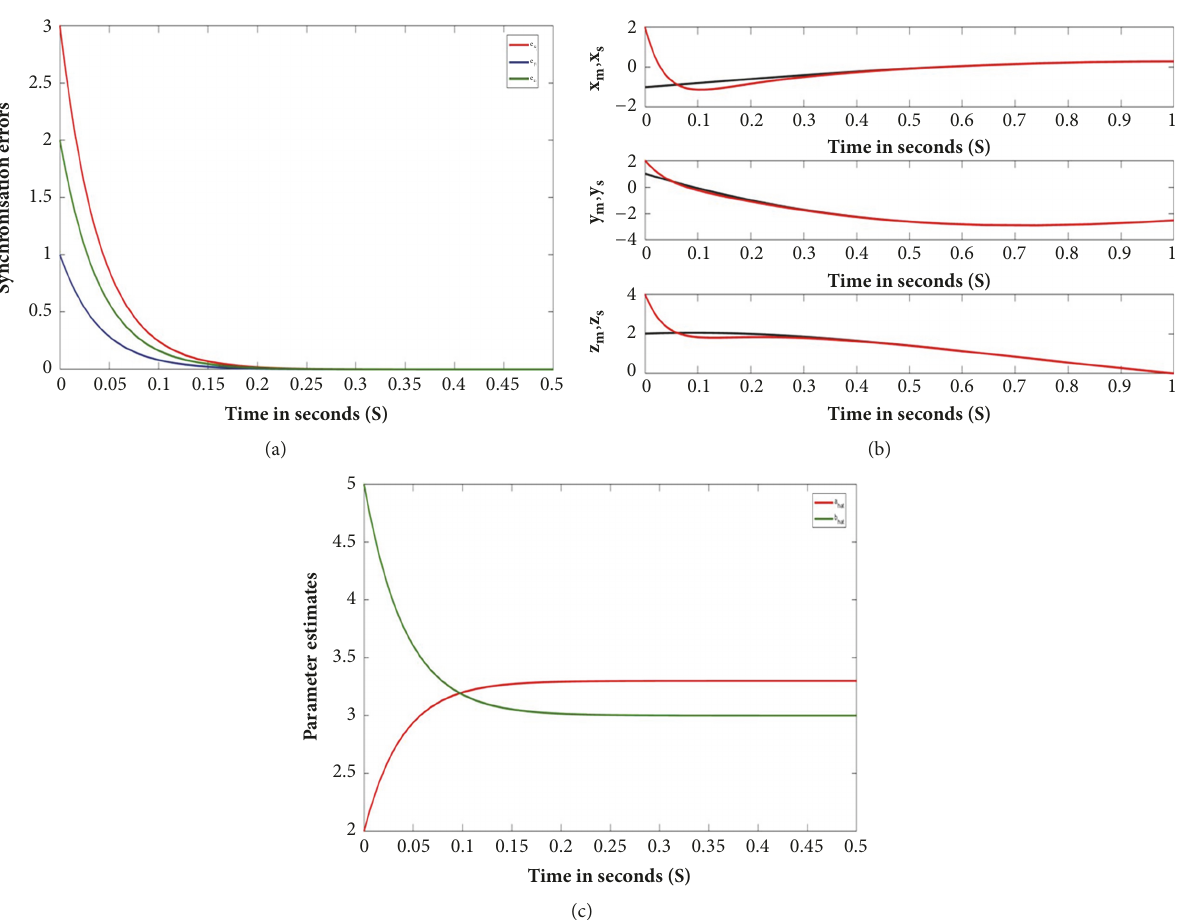
Figure 11: Time history of synchronization error variables (a), synchronized states (b), and estimated parameters (c).